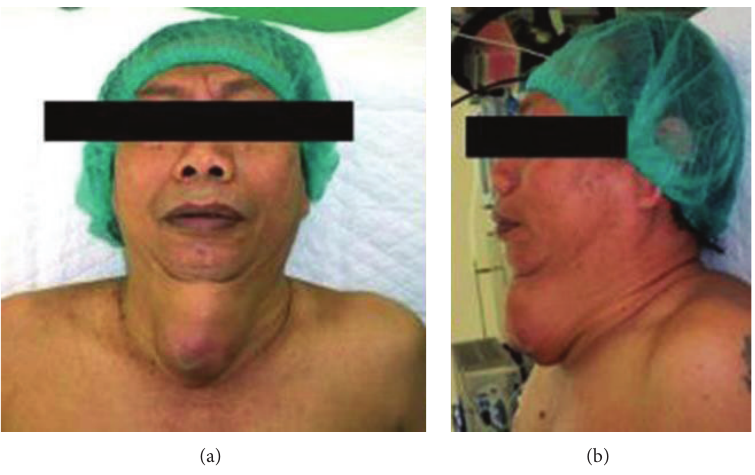
Figure 1: Clinical presentation of the